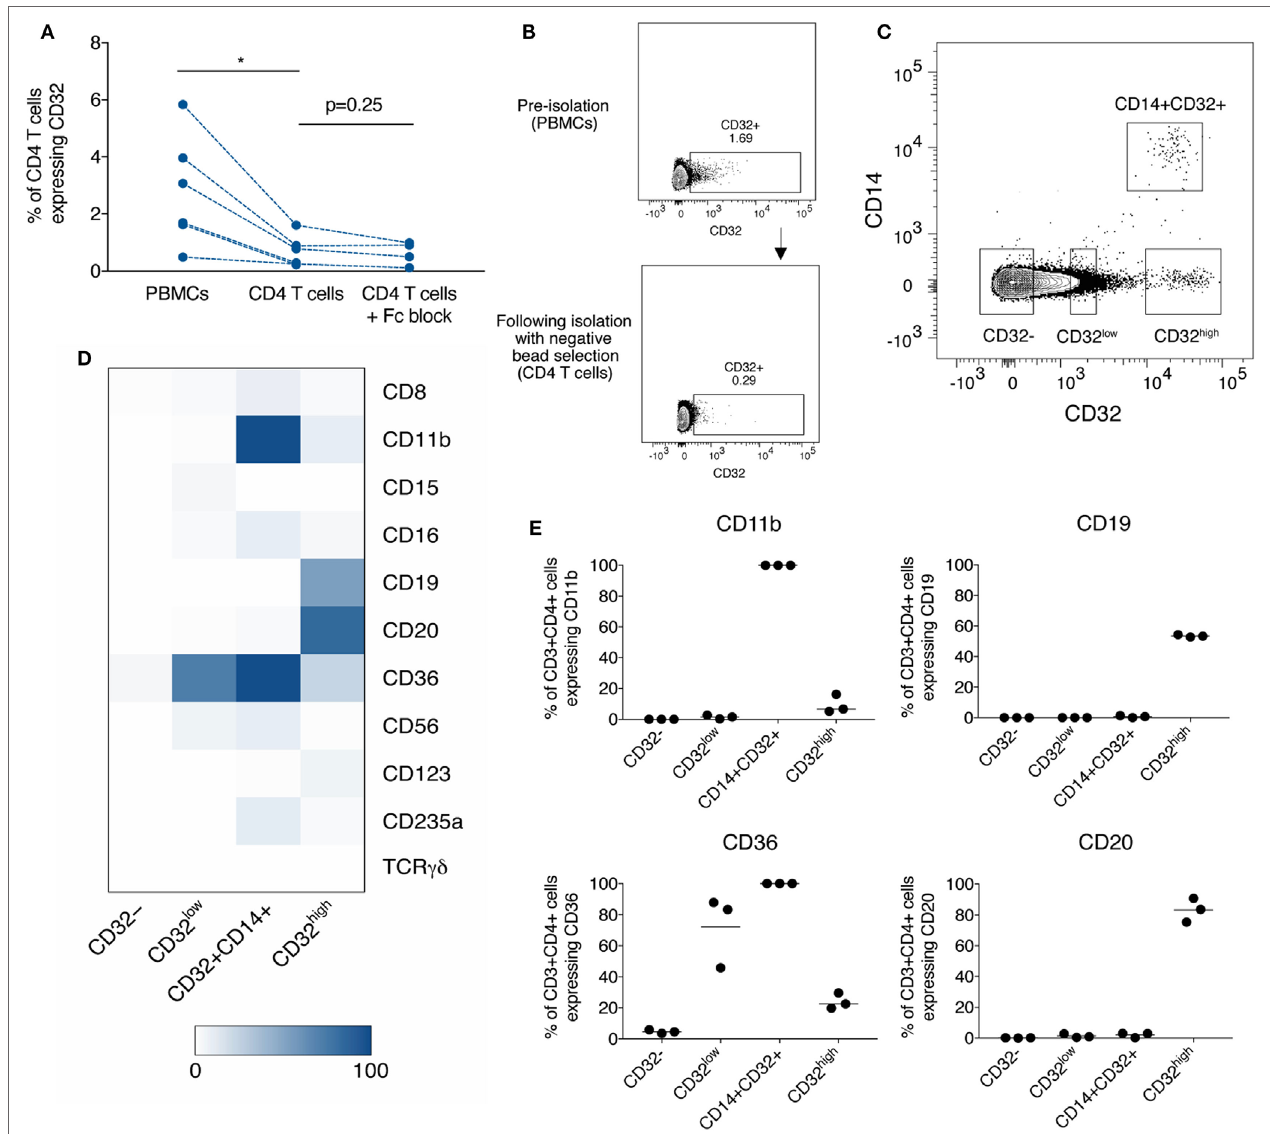
FigUre 1 | Depletion of diverse populations of CD32-expressing CD4 T cells by negative bead selection due to the expression of non-T cell markers. (a) The frequency of CD32 + CD3 + CD4 + T cells when measured in peripheral blood mononuclear cells (PBMCs), or in CD4 T cells purified by negative bead selection, with and without Fc block prior. (B) Representative gating of data shown in panel (a) . (c) Gating of three CD32-expressing populations based on differing levels of expression and CD14: CD32 low , CD32 + CD14 + , and CD32 high . (D) Heat-map showing the percentage expression of markers used in CD4 negative bead isolation kits on subsets of CD3 + CD4 + T cells [defined in panel (c) ]. Expression was measured by flow cytometry, and values are shown as the mean of three individual donors. (e) Percentage expression of CD11b, CD19, CD36, and CD20 on CD3 + CD4 + subpopulations as shown in panel (D) . Bar is shown at the